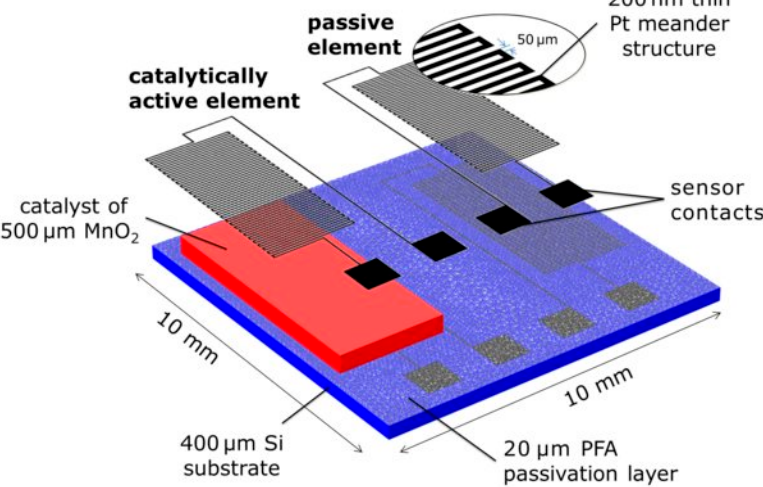
Figure 5. Schematic of a calorimetric H 2 O 2 sensor. It consists of two Pt-meander structures: one passive and the other catalytically activated by a MnO 2 layer. Reprinted with permission from ref [112]. Copyright 2017, Wiley-VCH GmbH.